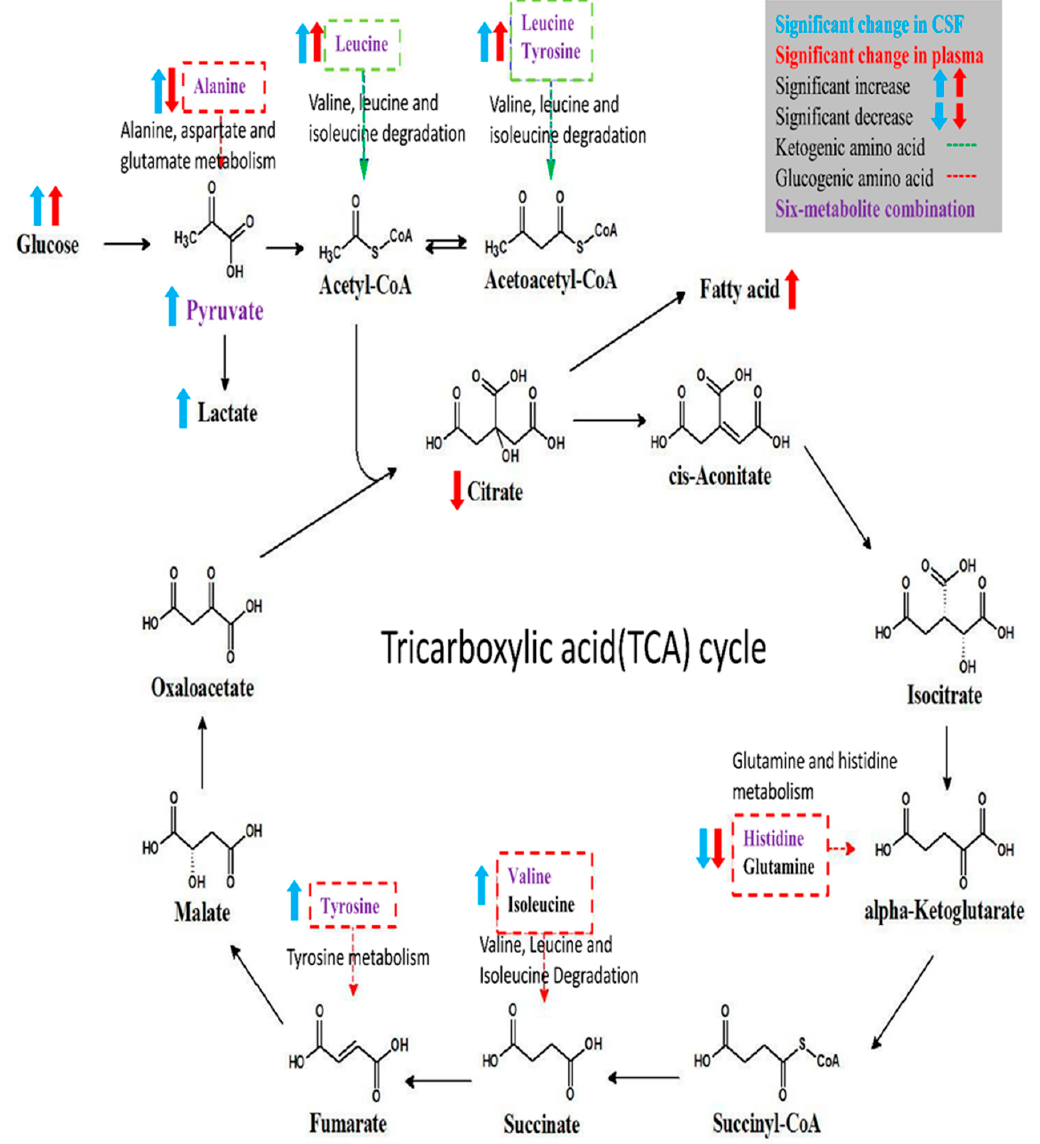
Figure 5. Schematic representation of significant metabolite alterations in CSF and plasma and involved metabolic pathways of six-metabolite combination.